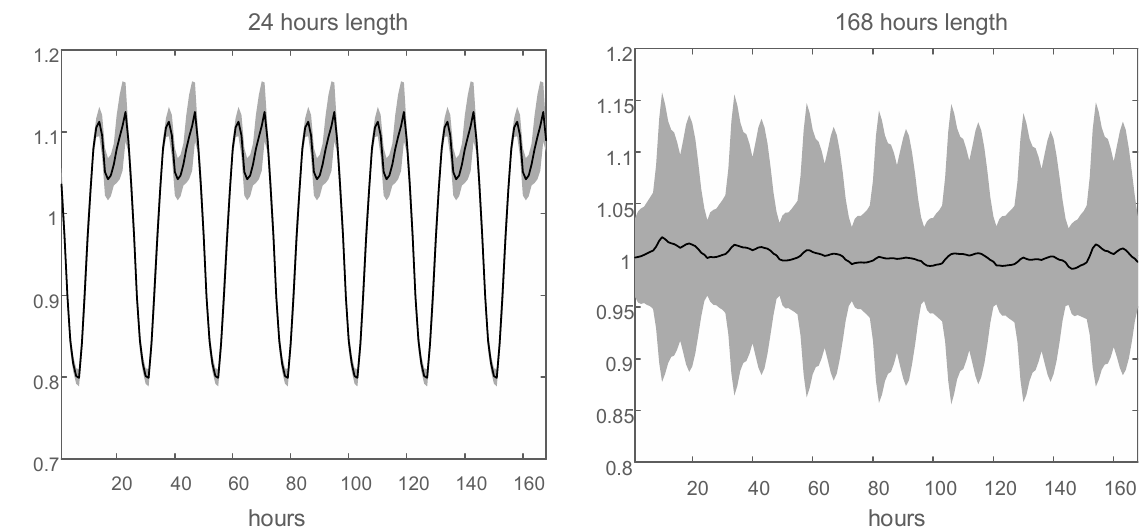
Figure 6. Distribution of the initial seasonal indices for the AMC 24,168 model using the simple method. In the left part, the seasonality of 24 hours is used, and in the right part the seasonality of 168 hours is used. The central line represents the average of the values, regardless of the time of the year, while the shaded area represents the variability with ± standard deviation.